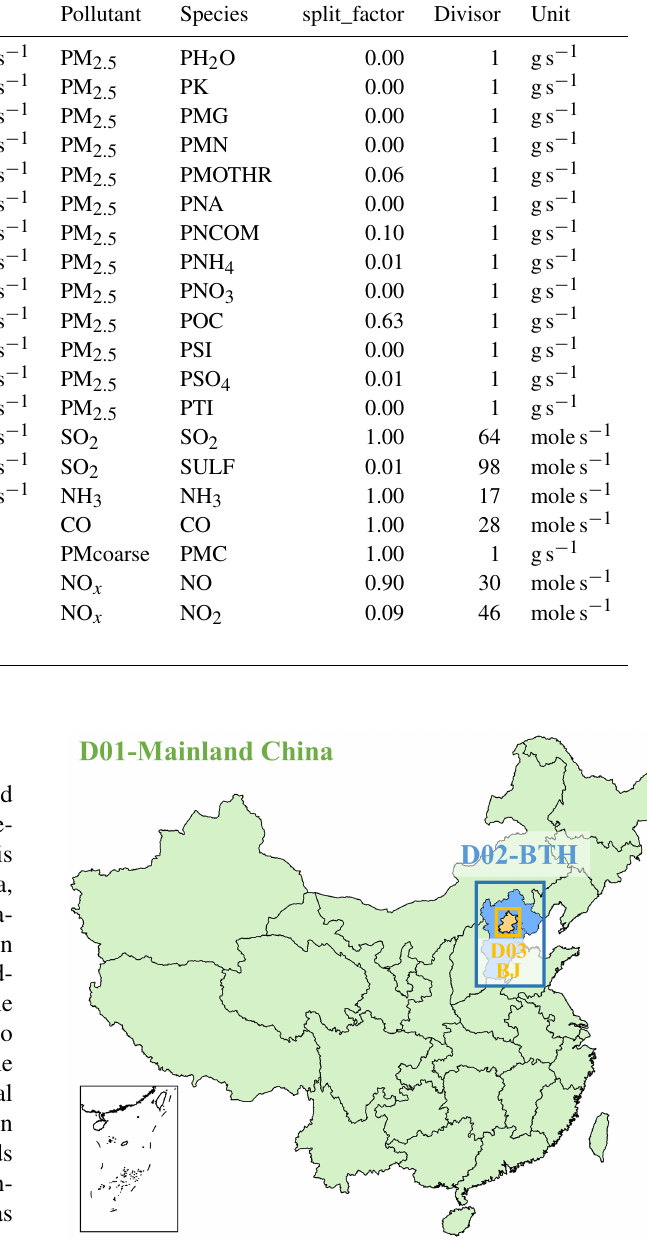
Figure 4. The three nested domains and their